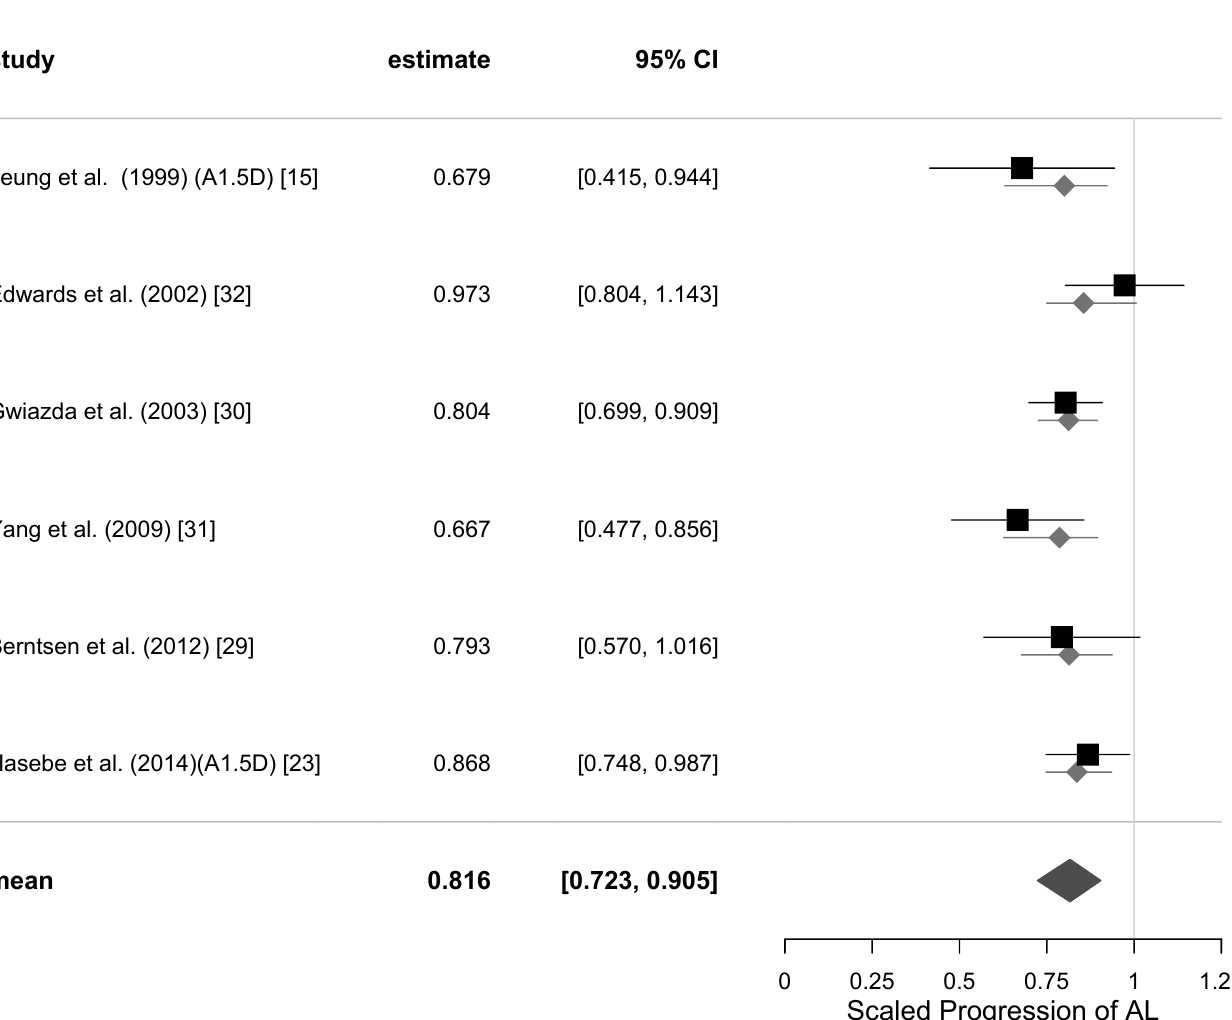
Figure 5. Forest plot for the scaled progression of axial length (AL) at 12-months follow-up with all trials